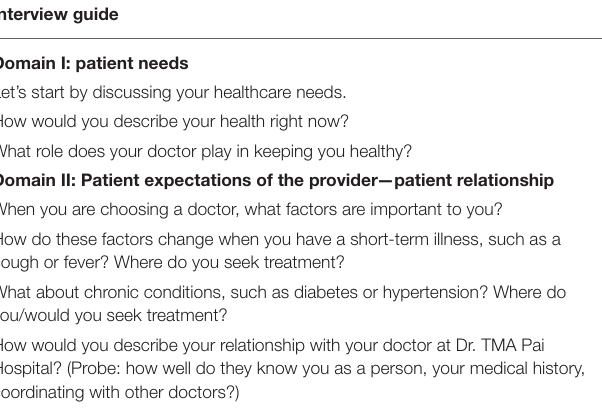
TABLE 1 | Qualitative interview guide